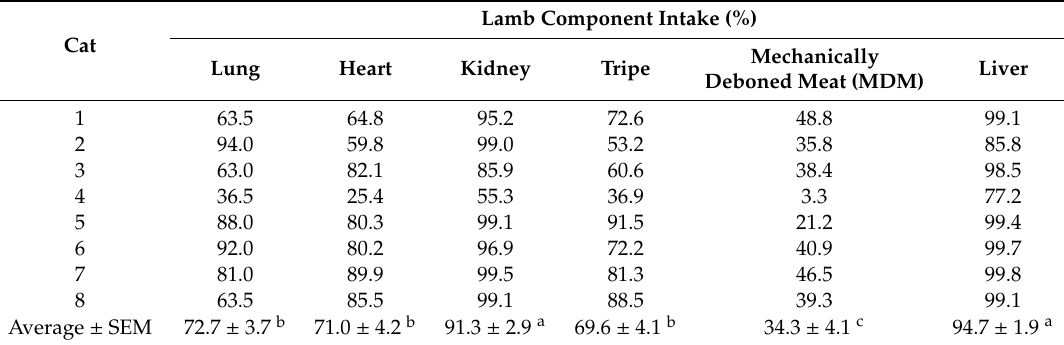
Table 1. Weekly percentage consumption results and final ranking of acceptance for the six lamb components.